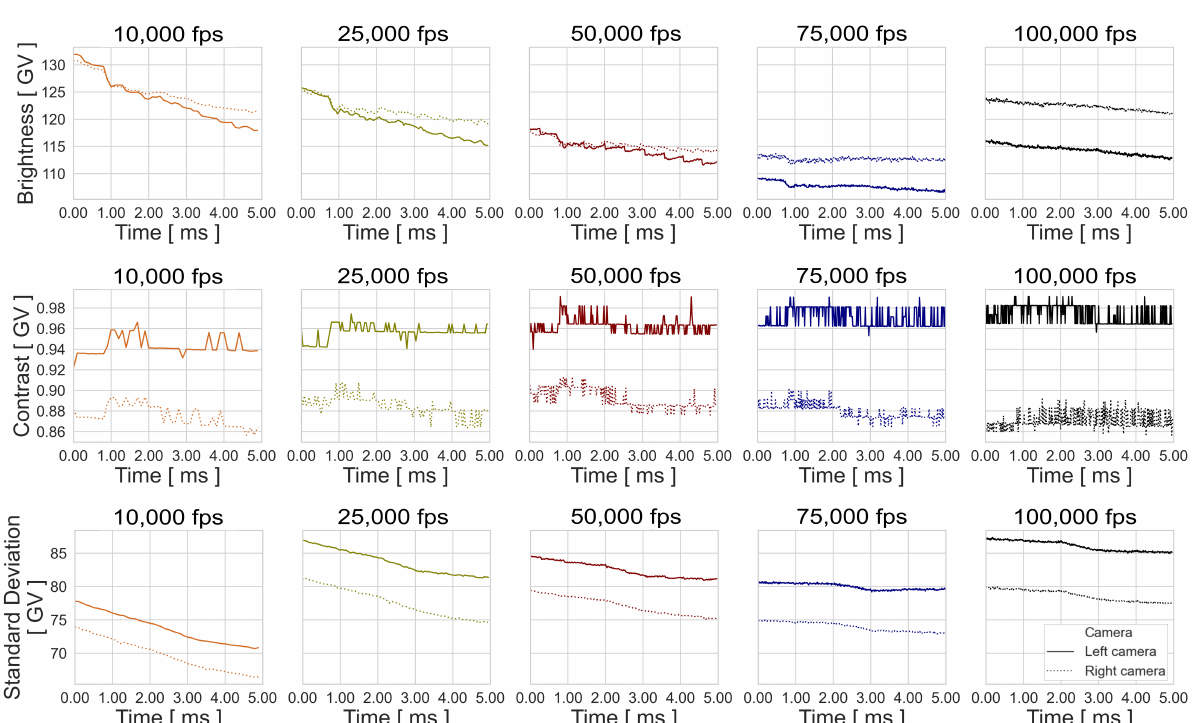
Figure A6. B P , C P , and Std P of experiment configurations images: Dynamic, 03 height, and SP